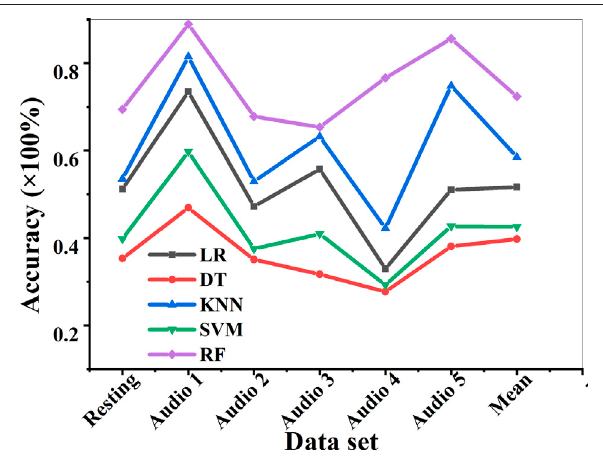
FIGURE 11 | The accuracy analysis of the classi fi cation algorithm on the test set.